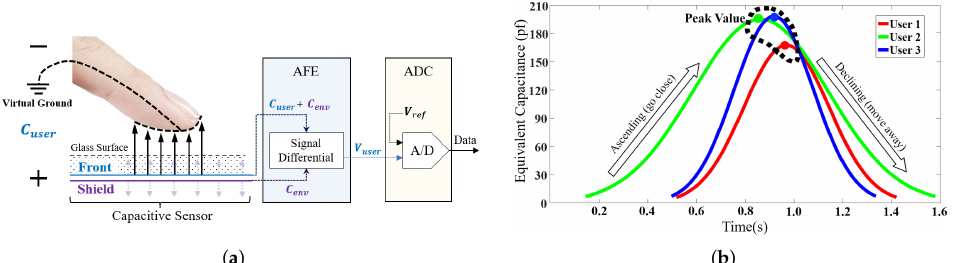
Figure 2. Using the capacitive sensors in a touchscreen, BioTouch continuously authenticates users according to their bio-capacitance during finger touching. ( a ) The collection of equivalent capaci- tance ( C user ). ( b ) The change of equivalent capacitance ( C user ) during